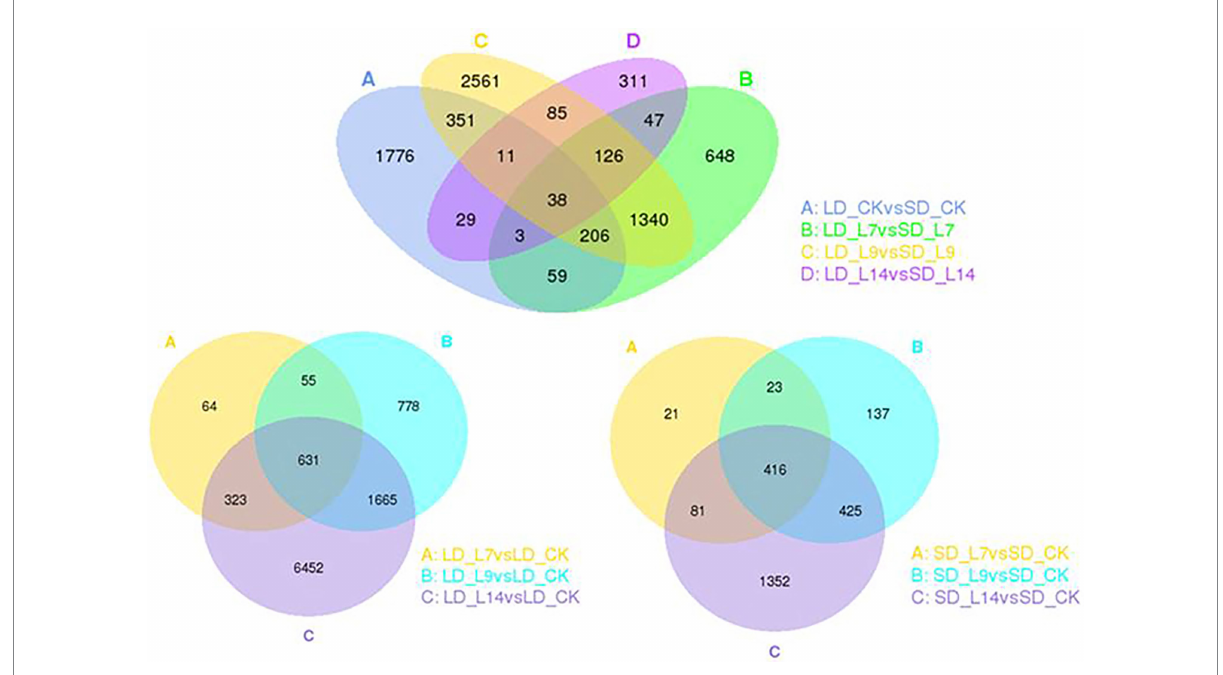
FIGURE 5 The Venn diagram of DEGs between transgenic GmFT3a soybean and control in LD and SD, respectively.